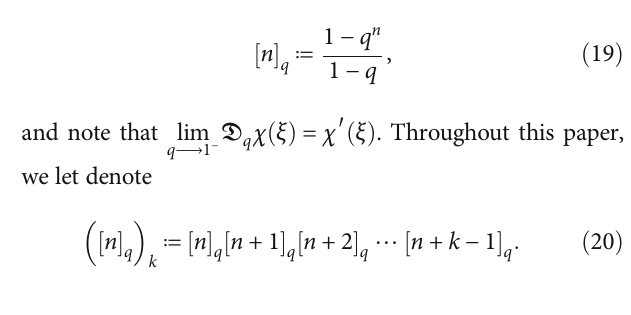
Figure 2: The image of the unit disc under the mapping of Δ τ